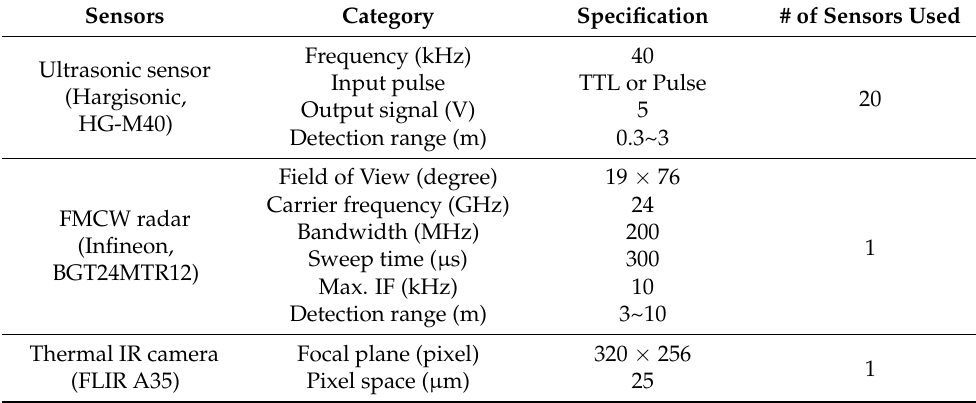
Table 2. The specification of the chosen sensors.